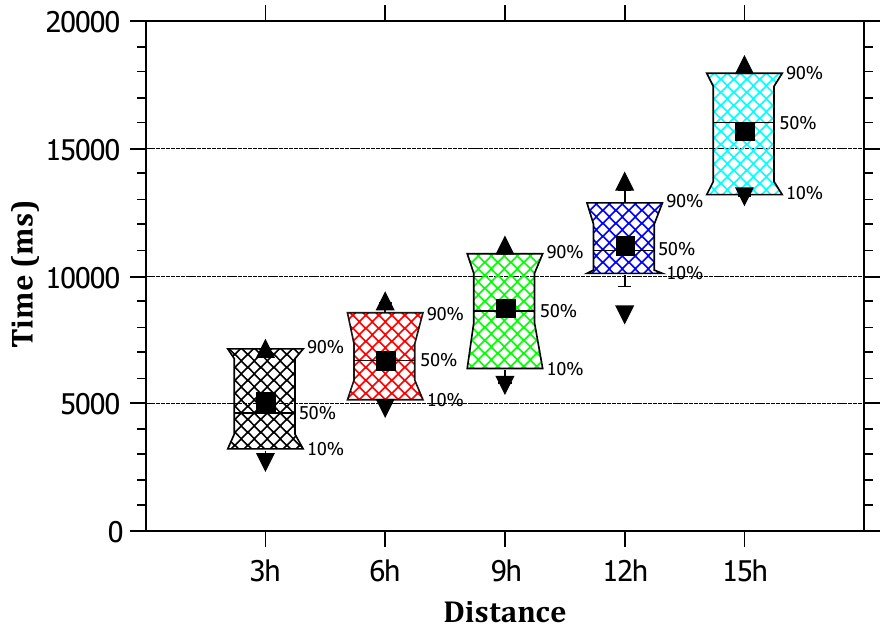
Figure 9. The relationship between the distance of the attack and the attack tracing